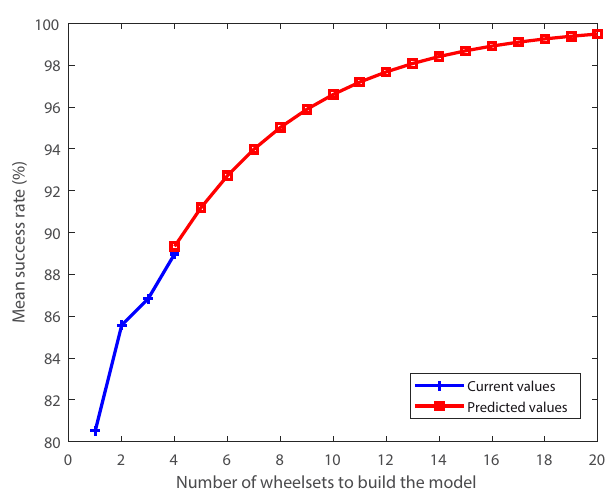
Figure 13. Current and predicted mean success rates for the models as a function of the number of wheelsets used to build the